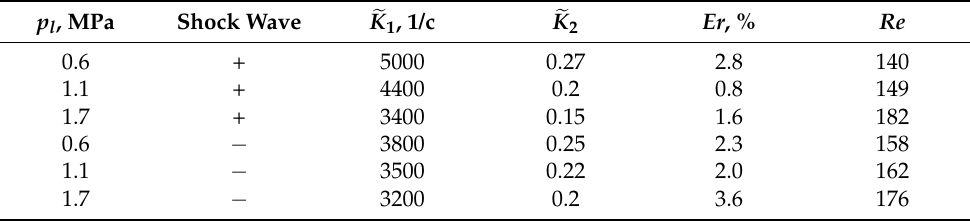
Table 2. Coefficients of the mathematical model at M = 2.0.